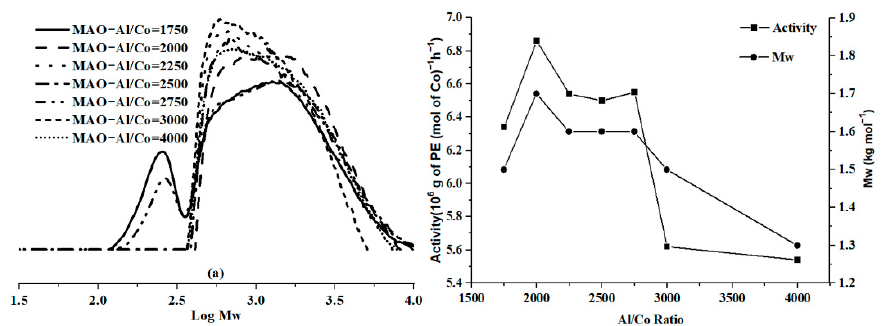
Figure 4. For Co6 /MAO: ( a ) GPC traces of the polymers obtained at different Al:Co molar ratios; and ( b ) plots of catalytic activity and M w of the resultant PE as a function of Al:Co molar ratio (entries 3, 6–11, Table 2).